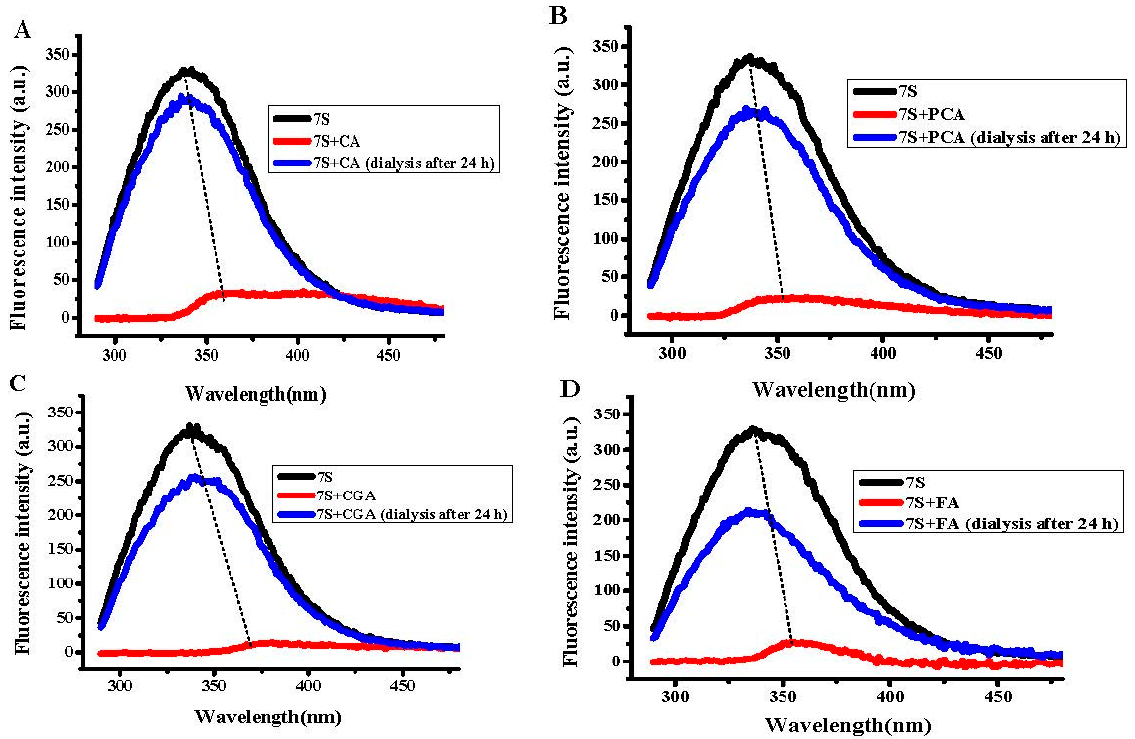
Figure 5. Fluorescence intensity of soy protein 7S treated with: ( A ) PCA; ( B ) CA; ( C ) GA; and ( D ) CGA after dialysis for 24 h. Conditions: 1 μ M soy protein 7S in 100 mM MOPS (5 mM NaCl), [PCA, CA, GA or CGA] = 100 μ M, pH 7.0, 25 C. λ Ex = 280 nm, slits for excitation and emission are 5 and 10 nm, respectively.